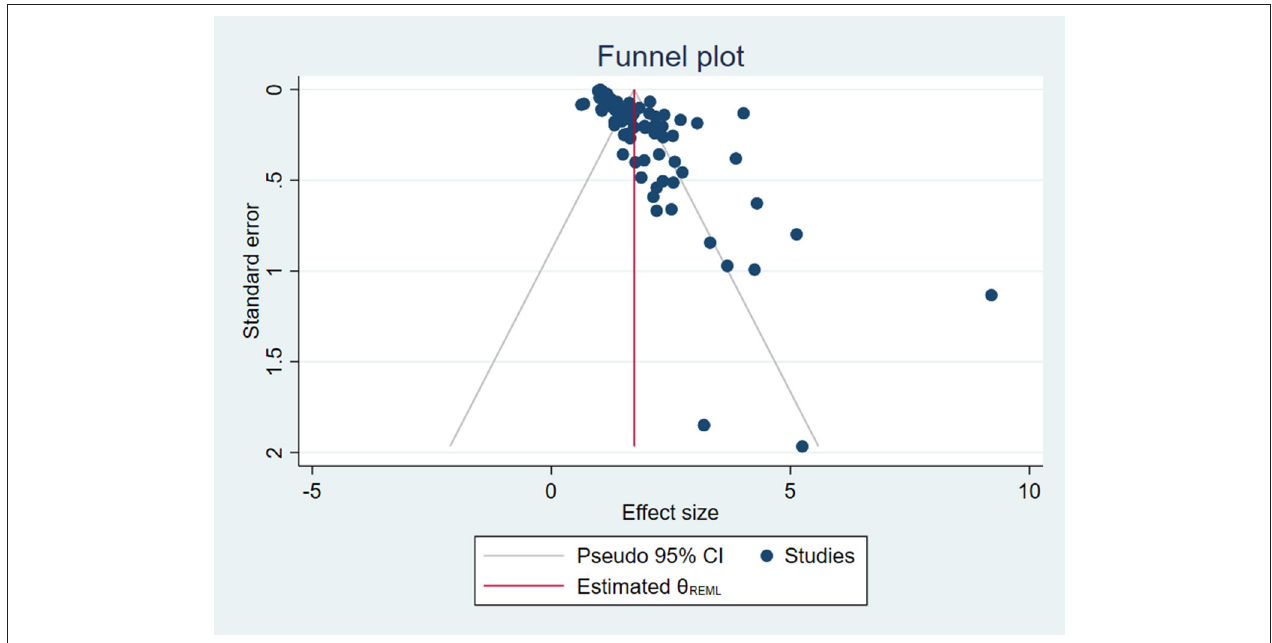
FIGURE 9 | Overall funnel